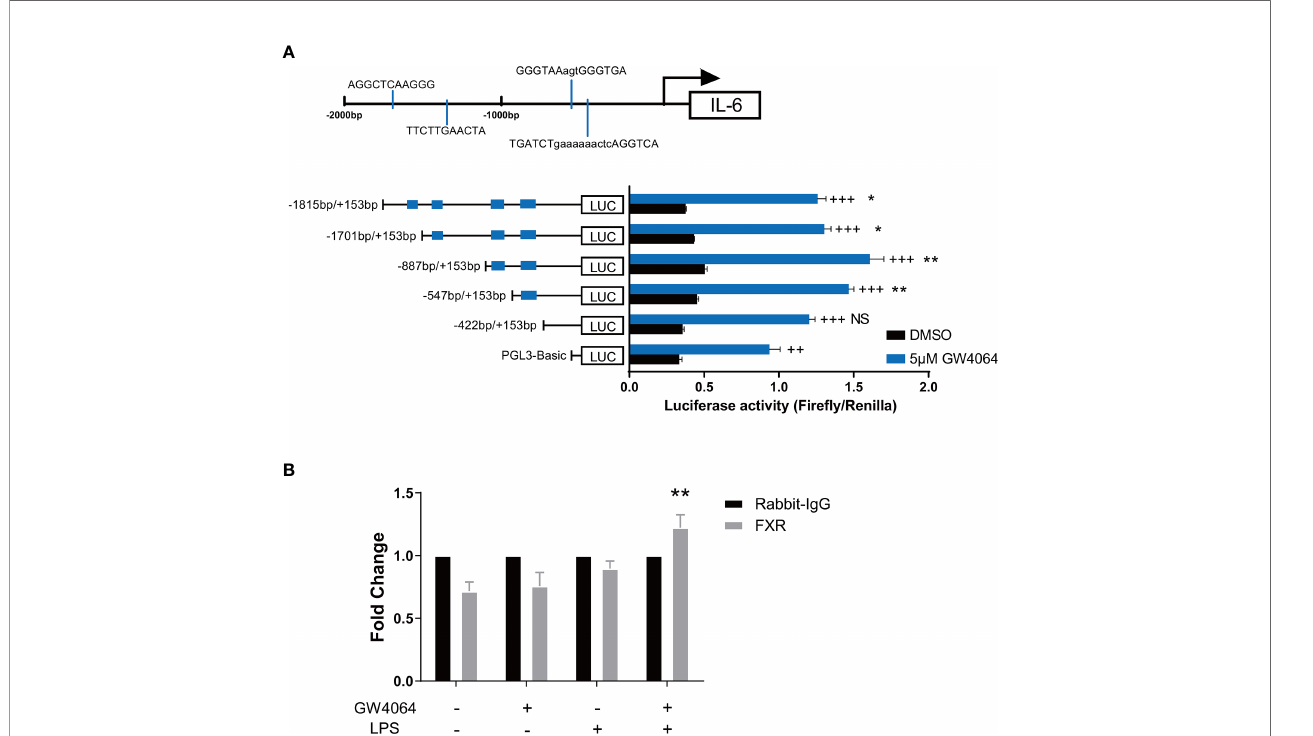
FIGURE 6 | FXR Binds to the Promoter Site of IL-6. (A) Four potential FXR binding sites in the promoter site of IL-6 were predicted based on the databases of PROMO and NUBIscan within about 2000bp upstream of the transcription start site of IL-6 (upper). Plasmids containing different numbers of the binding site based on the basic PGL-3 plasmid were constructed and co-transfected respectively with FXR-overexpression plasmids as well as Renilla plasmids together into 293T cells. 24h after the transfection, cells were then activated with or without 5 m M GW4064 for extra 24h. Luciferase activity was then evaluated with the dual luciferase assay (bottom). Data are shown as mean ± SEM. + means compared to unstimulated control and * means comparing to the luciferase activity of PGL-3 basic vector. ++ p < 0.01; +++ p < 0.001. *p < 0.05; **p < 0.01; NS, no signi fi cant difference, two-way ANOVA, followed by Sidak ’ s multiple comparisons test. (B) RAW